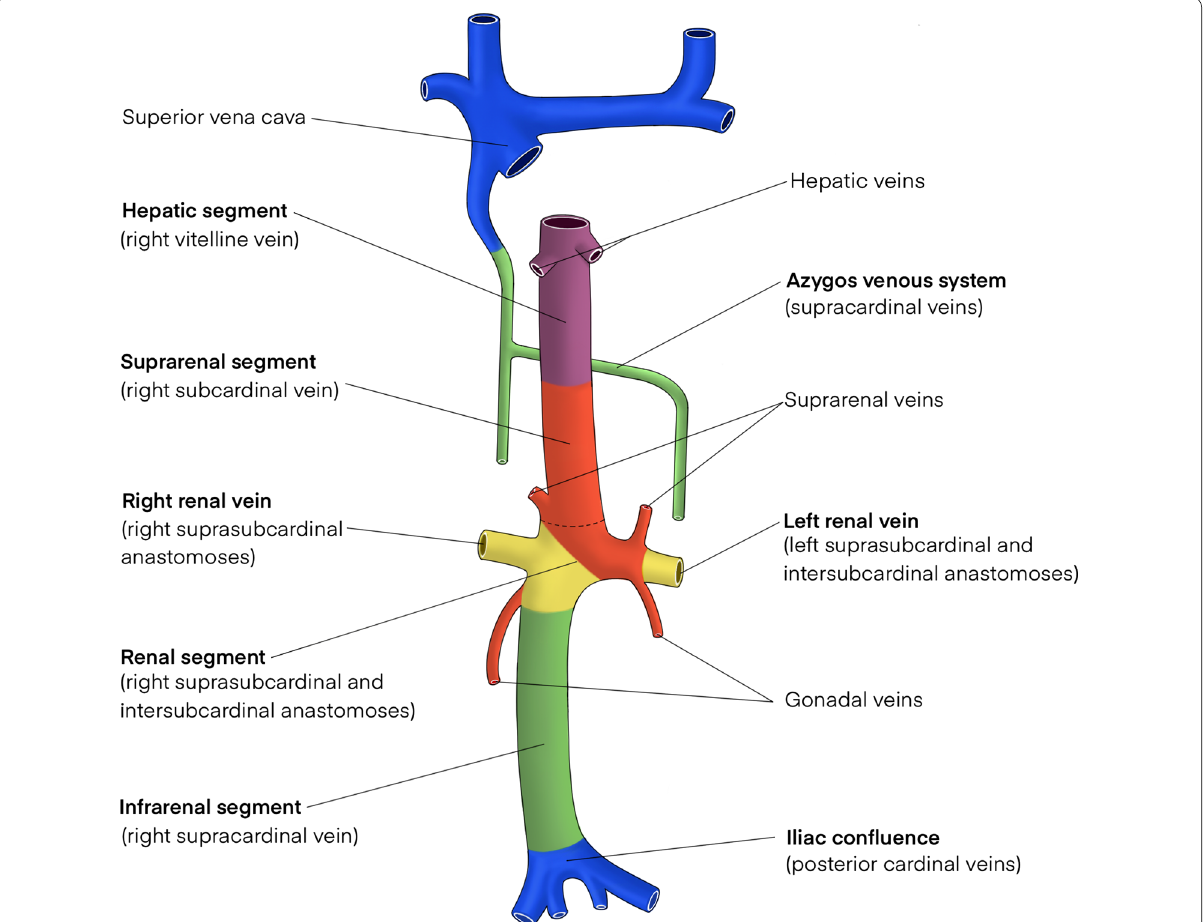
Fig. 2 The mature IVC is composed of infrarenal (right supracardinal vein), renal (right suprasubcardinal and intersubcardinal anastomoses), suprarenal (right subcardinal vein) and hepatic (vitelline veins) segments. Renal and suprarenal segments are separated by the dashed line. Posterior cardinal veins persist as paired common iliac veins which join to form the iliac confluence, whilst supracardinal veins contribute to the azygos venous system draining into the superior vena cava. The gonadal and suprarenal veins are derived from subcardinal